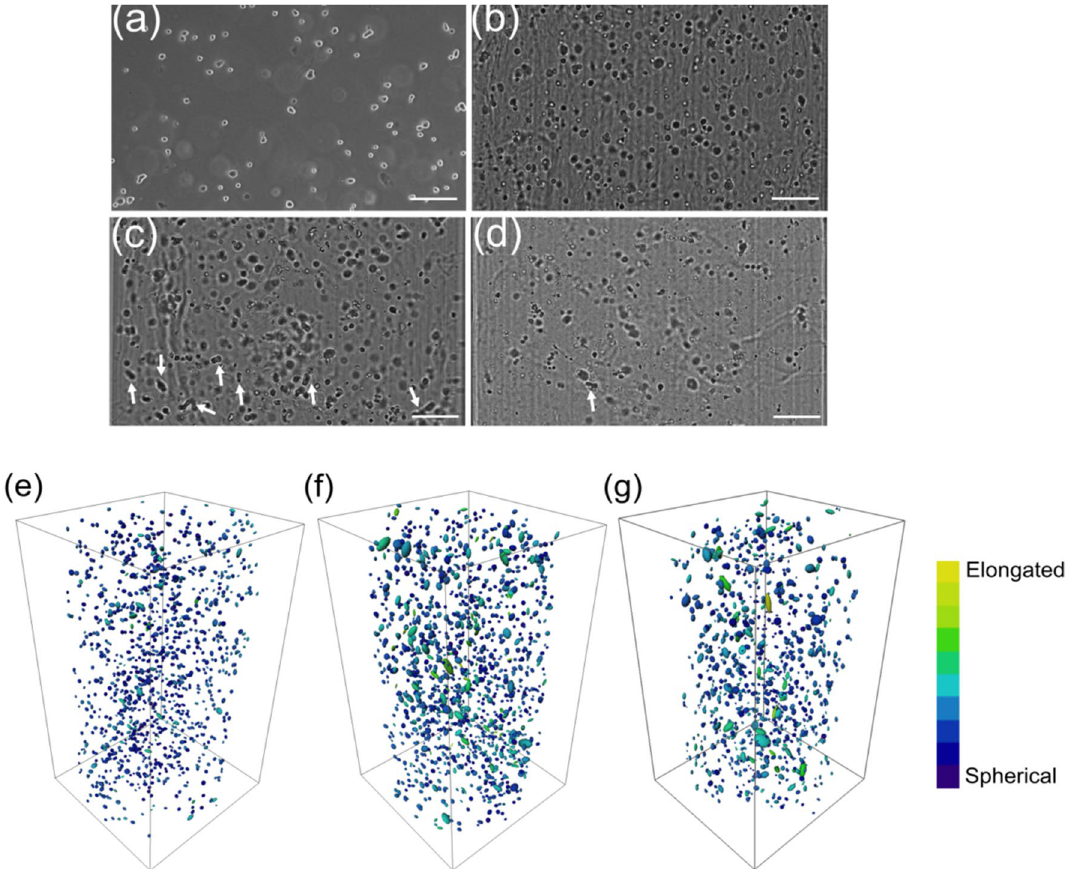
Figure 3. ( a ) 2D phase contrast image of human lung fibroblast (WI-38) cells in a culture flask acquired using a 5 × objective; representative OPT bright-field projection images of the same cells cultured for 7 days in ( b ) GG, ( c ) gelatin-GG, and ( d ) Geltrex hydrogel; ( e – g ) visualization of 3D reconstructed images of cells in ( b – d )). The arrows indicate large size and elongated cells. The color scale was assigned with darker blue indicating cell sphericity to lighter green and yellow indicating cell elongation. The scale bar in the images represents 200 µm.